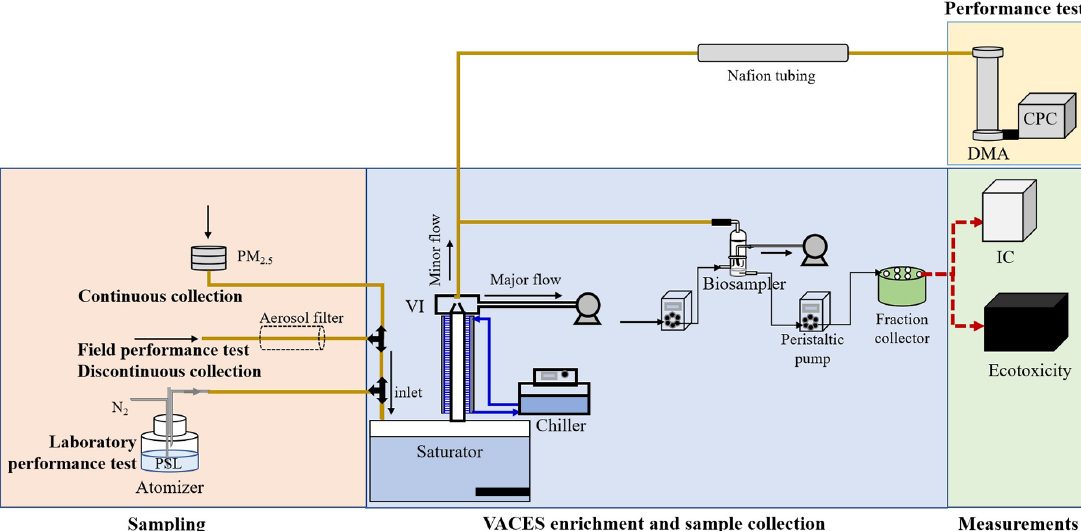
Figure 1. Setup for performance test and field sample collection. The experiments referring to VACES including laboratory and field perfor- mance tests, discontinuous and continuous sample collections, and their measurements. In the laboratory performance test, air flow passed through the atomizer, VACES (saturator-condensation tube-virtual impactor), Nafion tubing, DMA and CPC successively. For the two field performance tests, in the first one, air flow passed through VACES, Nafion tubing, DMA and CPC successively, and in the second, one air flow passed through the aerosol filter, VACES, Nafion tubing, DMA and CPC successively. During the discontinuous sample collection, particles followed the flow line of VACES to the biosampler. For the continuous sample collection, particles were collected from the PM 2 . 5 sampler, VACES and biosampler to the fraction collector. Both types of collected samples were used for online ionic measurement by ion chromatography and online eco-toxic assay by a photobacterium acute toxicity analyzer (an integrated instrument with automatic operation controlling by a